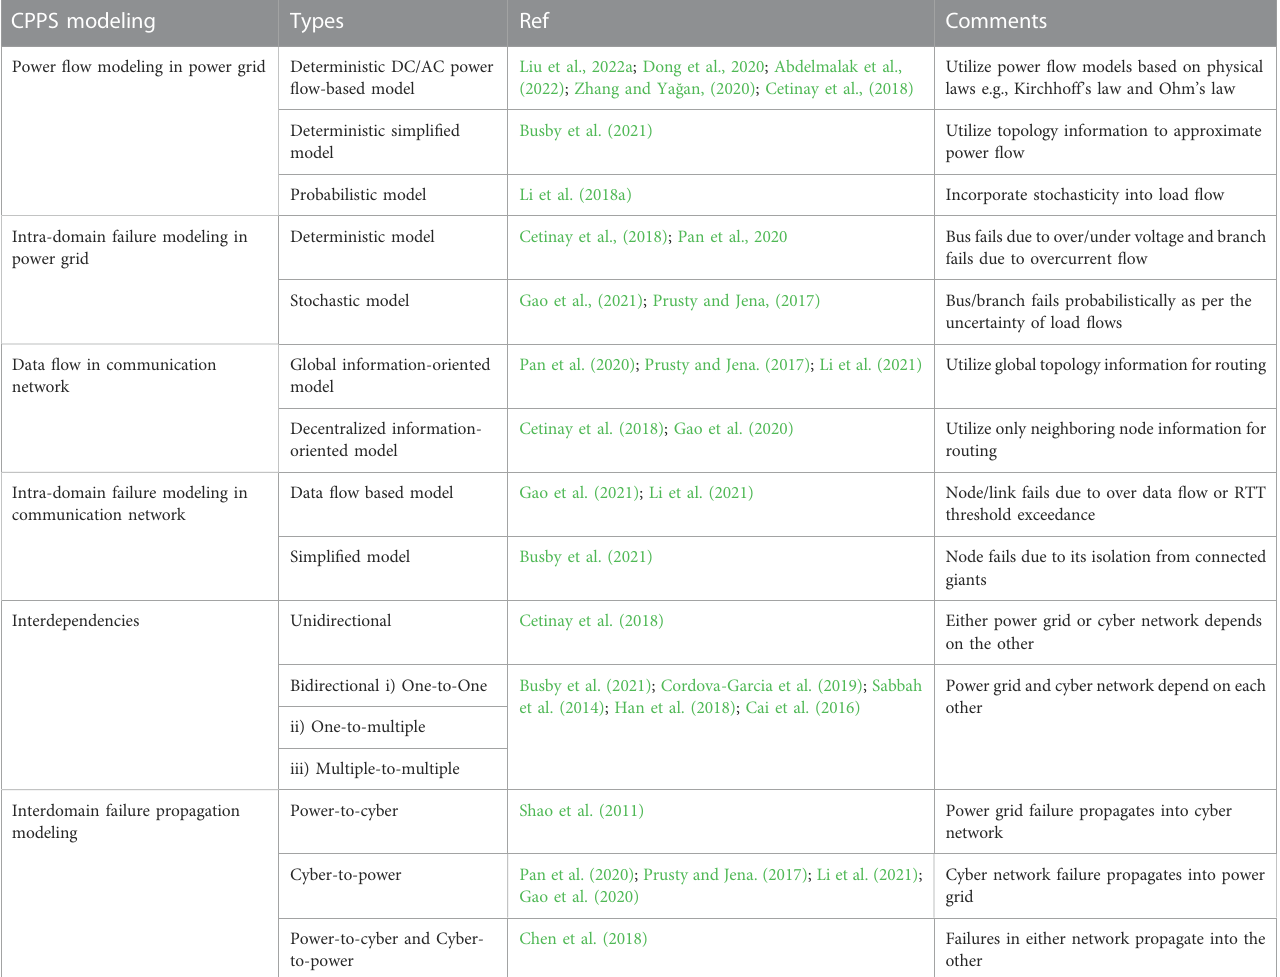
TABLE 1 Summary of CPPS